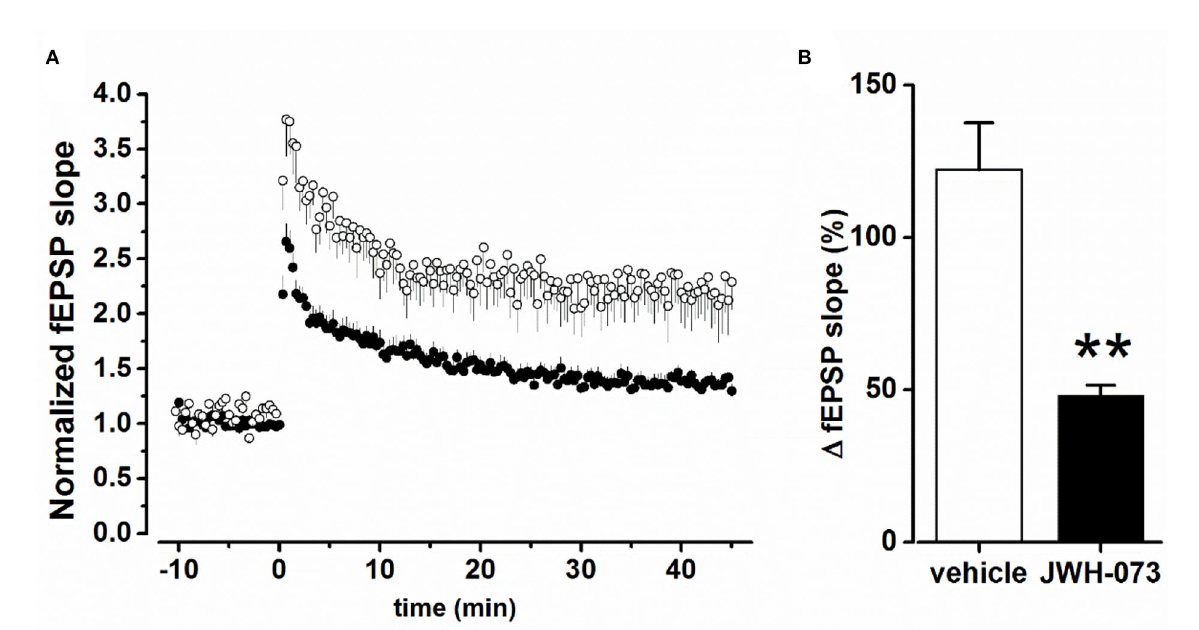
FIGURE3 (A) Time course of fEPSP after TB5 tetanic stimulation inducing LTP. ( (cid:13) ) = control/vehicle values normalized vs. pre LTP average amplitude ( n = 6); ( • ) as above at steady state effect of JWH-073 1 µ M ( n = 13). (B) Averaged steady peak fEPSP at stable LTP. Data as fEPSP % slope ± s.d., comparing control/vehicle (hollow bar) and after JWH-073 (black bar). ** p < 0.01 with t - Student test for unpaired data.